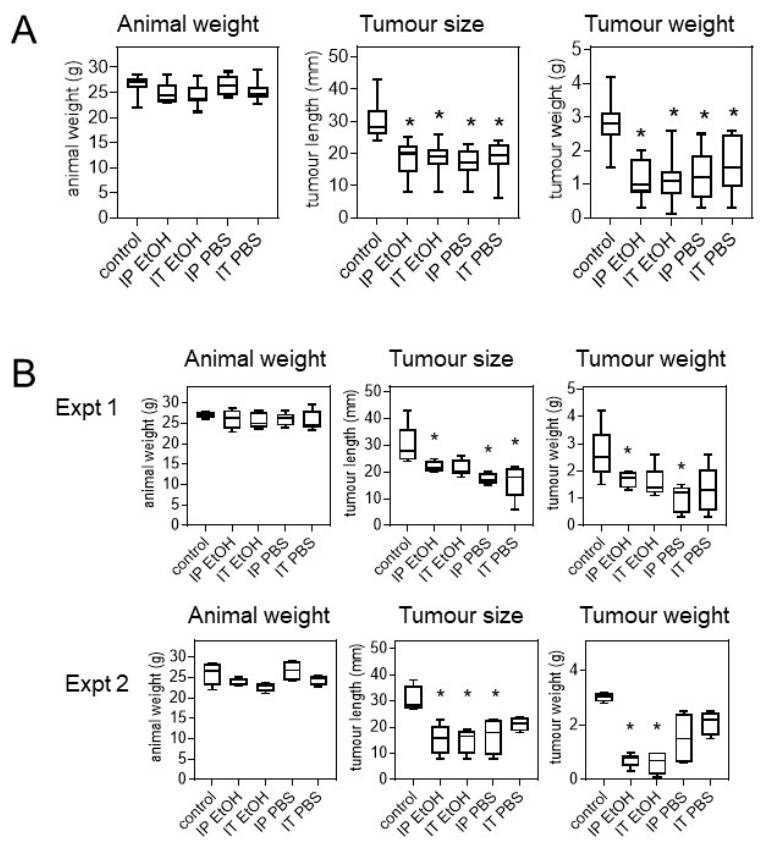
Figure 5. Tumour weight was evaluated following treatment with Uncaria tomentosa . Animals were injected with B16-BL6 tumour cells and then received intraperitoneal (IP) or intra-tumour (IT) injections with Uncaria tomentosa , extracted with 70% ethanol (EtOH) or PBS, pH 7.4, (PBS) that had been freeze-dried and resuspended in PBS. At endpoint, the mice were euthanised and the tumours were removed to determine the tumour diameters (size) and weights, and the mouse body weights. The average measures for each of the five treatment groups was plotted using a box and whisker plot (whiskers are 95% interval) for the ( A ) combined experiments ( n = 8–10) or ( B ) two separate experiments ( n = 4–5). The results revealed that there were significant differences ( p < 0.05) between each of the four treated groups compared to the control (*) using ANOVA and Tukey post hoc statistical